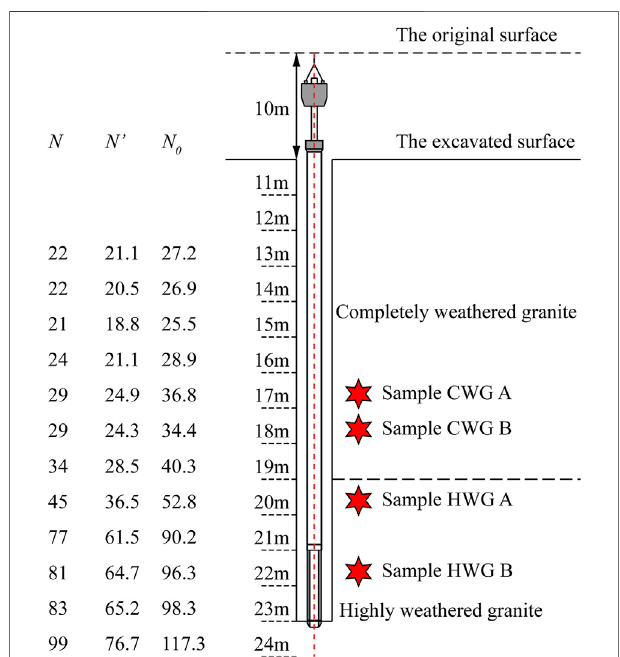
FIGURE 3 | SPT results and sample acquisition